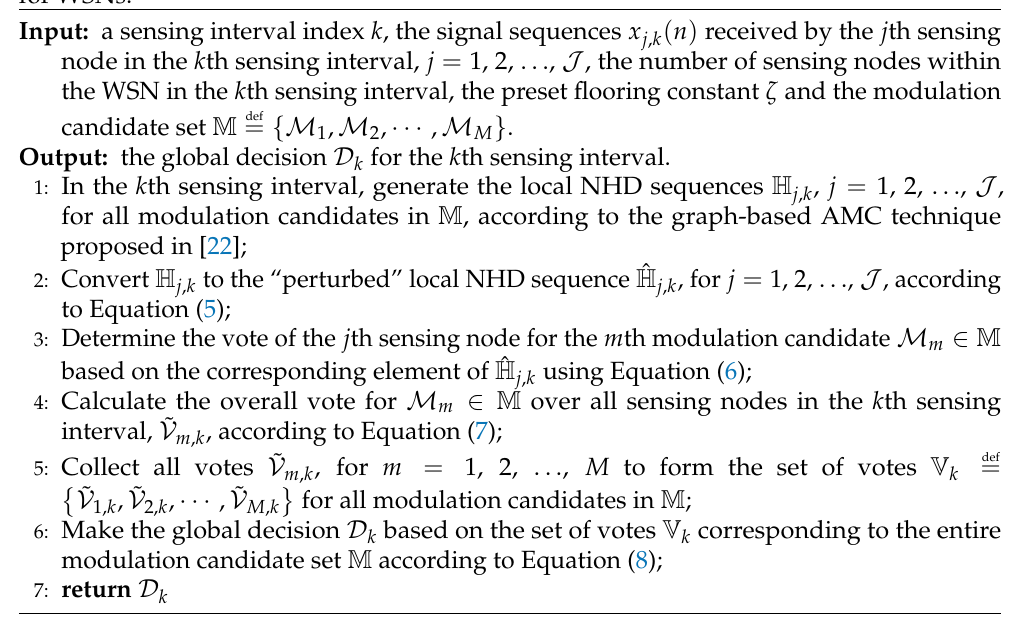
Algorithm 1 Our proposed new CAMC scheme using vectorized soft decision fusion for